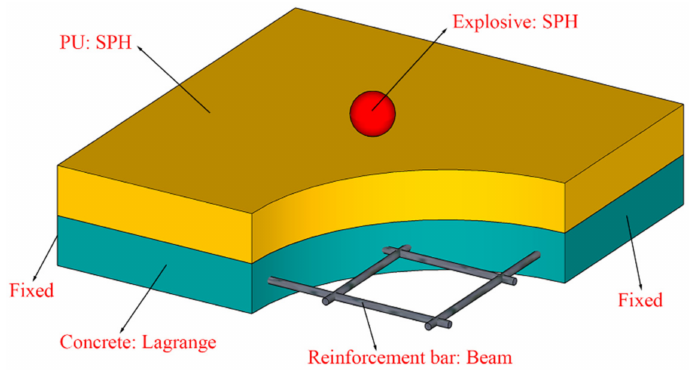
Figure 12. SPH–FEM coupling model.